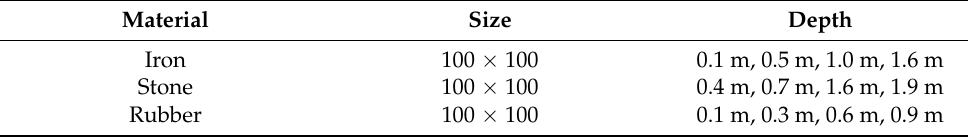
Table 3. Test dataset